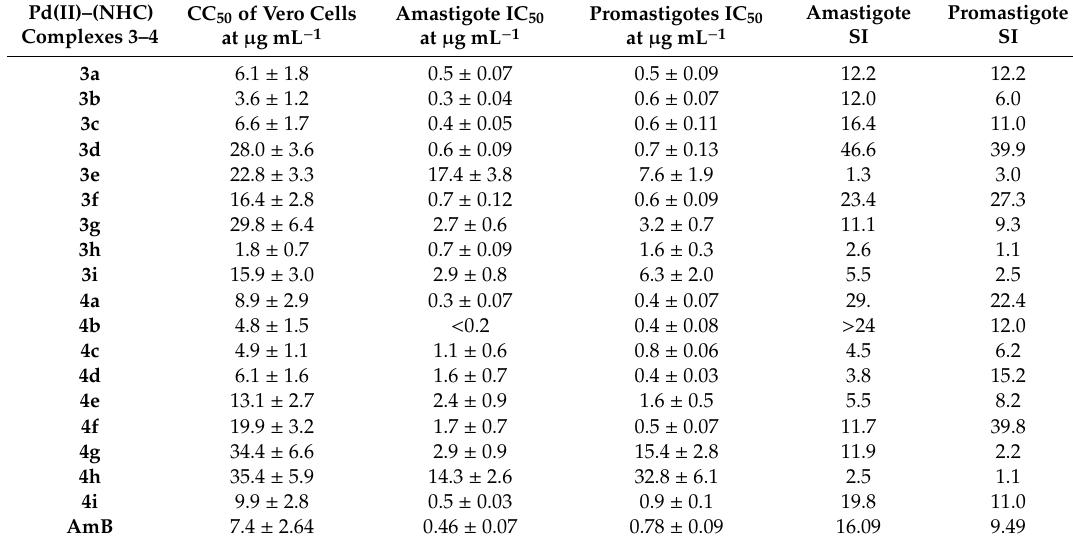
Table 3. Antileishmanial activity of Pd(II)–N-heterocyclic carbene (NHC) complexes 3–4 against L. major promastigotes and amastigotes.